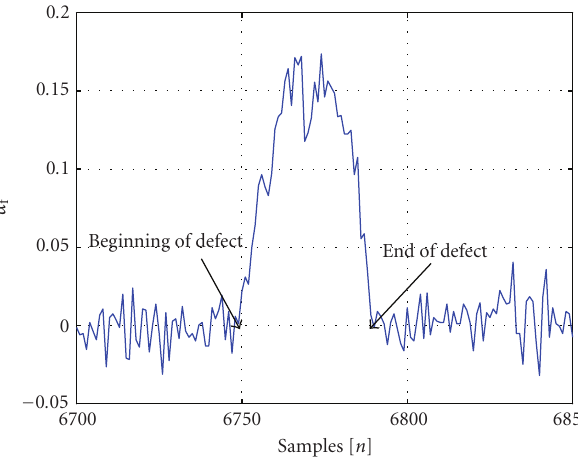
Figure 9: A zoom on the α f during scratch no.